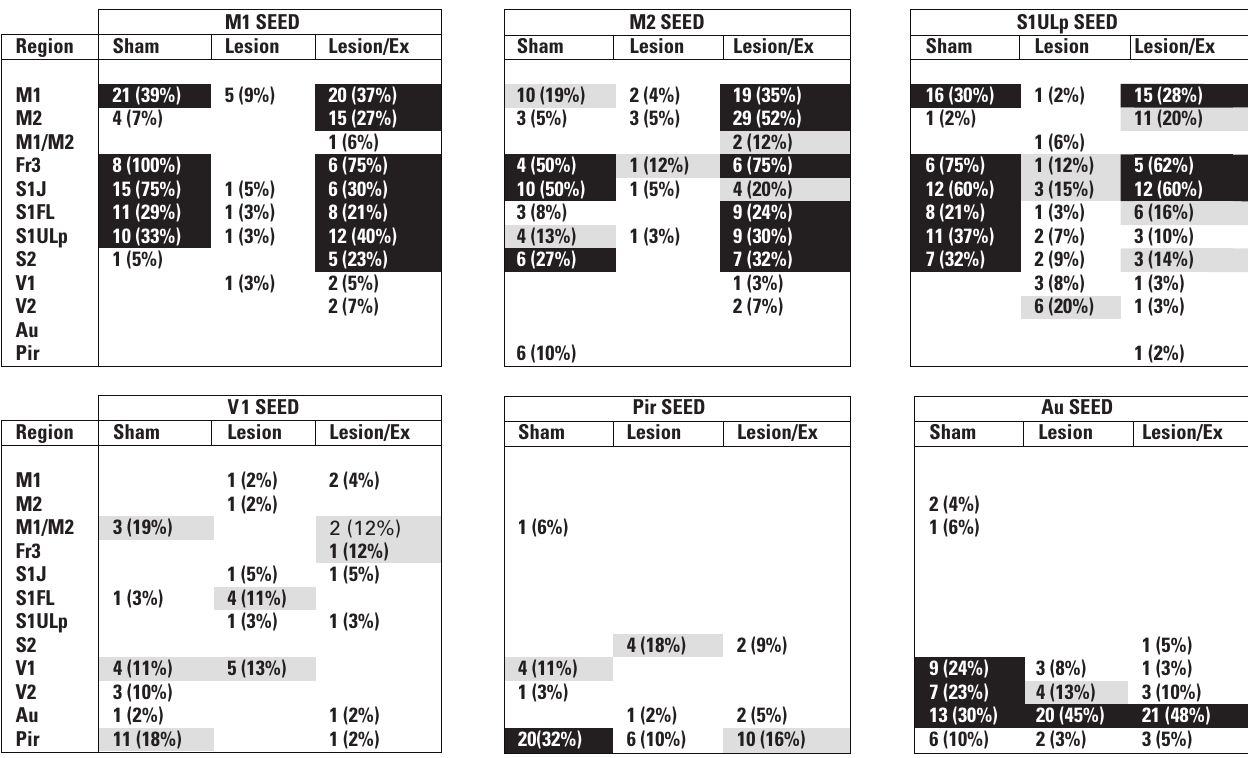
Table 1 | Total number of significant positive correlations of select cortical seeds with other cortical regions. M1 SEED M2 SEED S1ULp SEED Region Sham Lesion Lesion/Ex Sham Lesion Lesion/Ex Sham